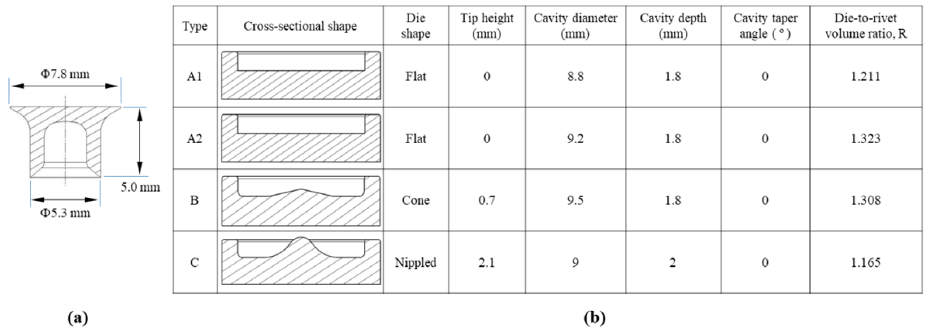
Figure 2. ( a ) The geometric dimensional parameters of the SPR rivet and ( b ) the die types used in this study.